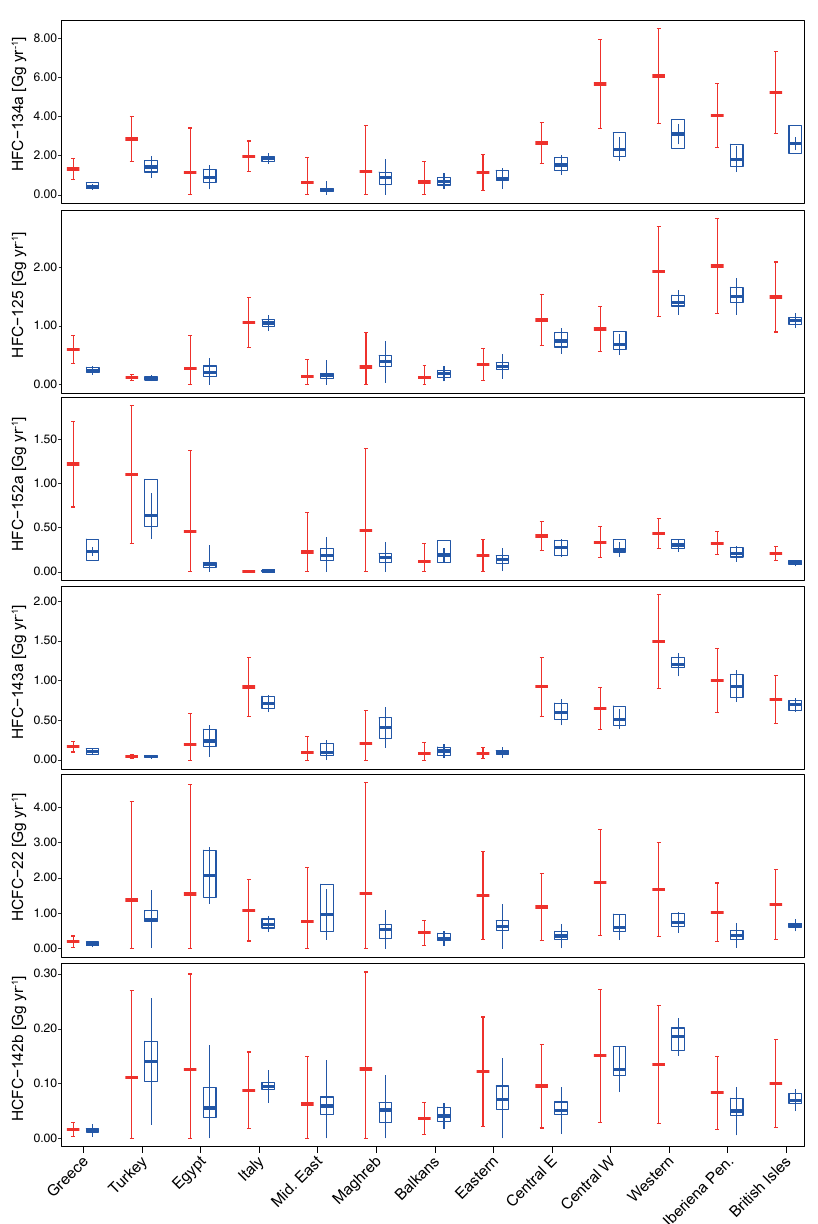
Figure 7. Annual emissions of 2013 for the aggregated regions. A priori emissions are shown in red, with uncertainty giving the 95% confidence range. For the a posteriori estimates boxes show the range of all sensitivity inversions, whereas the thick horizontal line gives the mean of all sensitivity inversions. In addition, the blue error bars give the analytic uncertainty (95% confidence level) averaged over all uncertainty